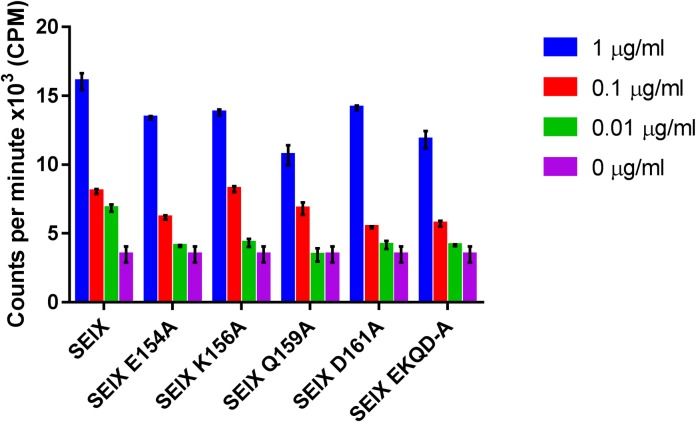
Neutrophil binding-deficient mutants of SElX retain mitogenic activity.Isolated human PBMC were stimulated with recombinant SElX and sialic acid-binding mutants. After 72 h incubation, proliferation was determined by analysing the incorporation of [3H] thymidine. Results shown are the means of triplicate measurement from 3 human donors ± standard deviation of the mean.